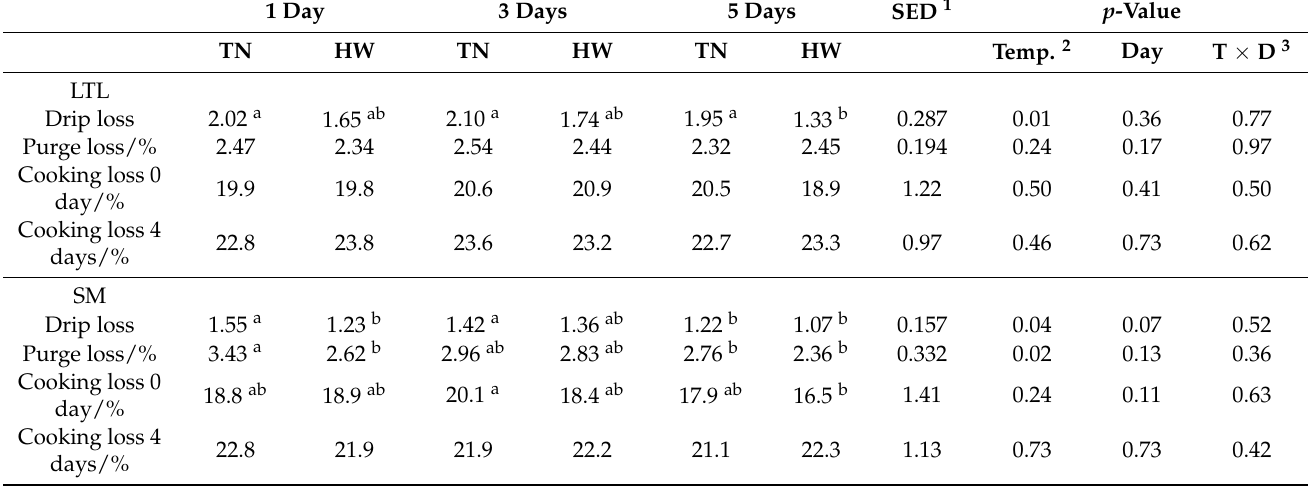
Table 1. The effect of temperature (thermoneutral, TN vs. heatwaves, HW) and heat exposure duration (1 vs. 3 vs. 5 days) on drip, purge and cooking loss of longissimus thoracis et lumborum (LTL) and semimembranosus (SM) muscle in 4 days’ overwrap retail display in lambs ( n = 12 per group).